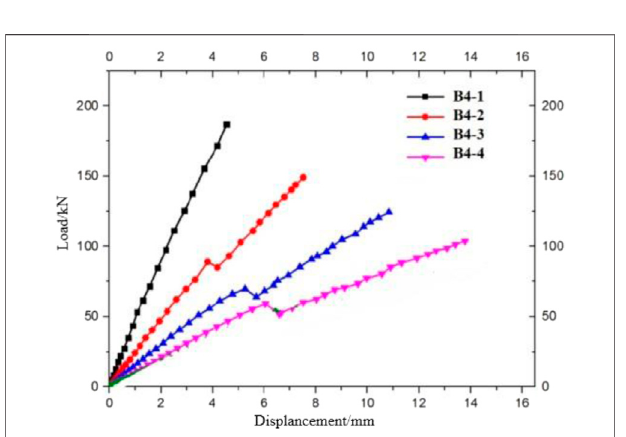
FIGURE 11 | Load – displacement curves of composite beams with different shear-span ratios.